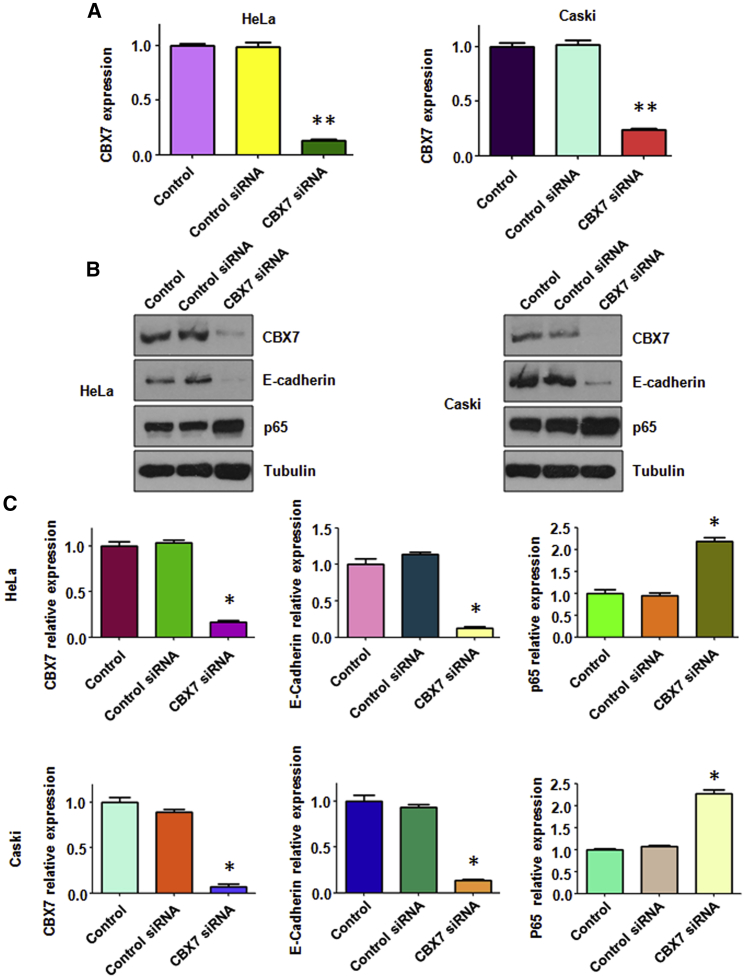
Downregulation of CBX7 Decreases E-cadherin and Increases the NF-κB Level(A) The CBX7 mRNA level was detected by real-time PCR in both HeLa and Caski cells with CBX7 siRNA transfection.**p < 0.01 versus control group. (B) Western blot was performed to analyze the protein level of CBX7, E-cadherin, and NF-κB in cervical cancer cells with CBX7 siRNA transfection. (C) Quantification of the expression of CBX7, E-cadherin, and NF-κB was performed. *p < 0.05 versus control group.